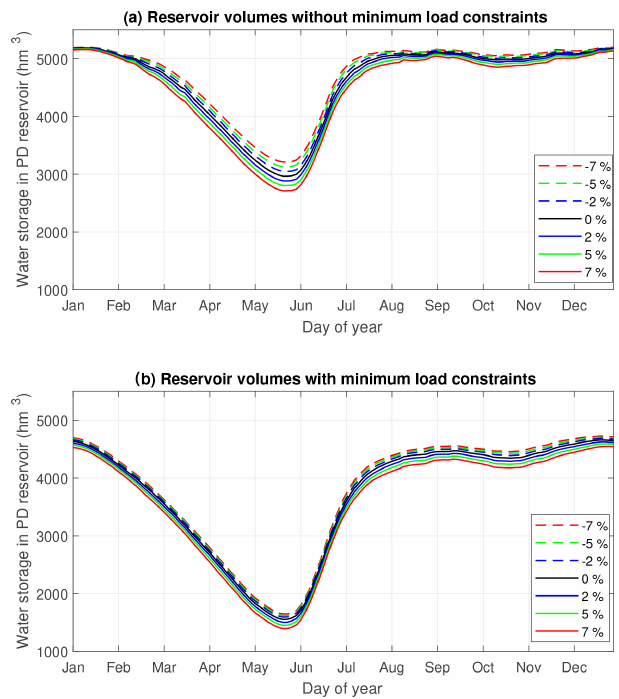
Figure 8. Average reservoir storage level as a function of time for various bias levels without (a) and with (b)